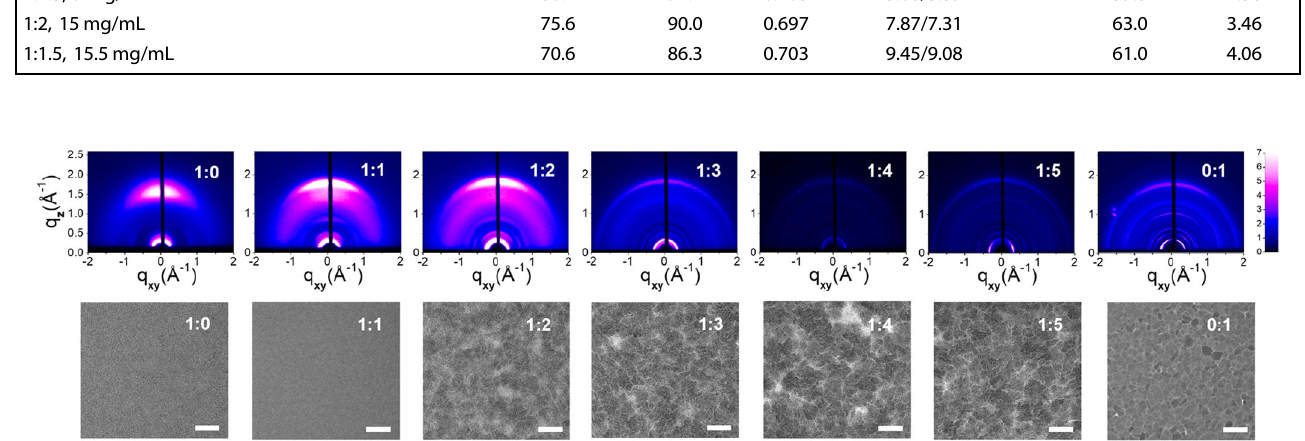
Fig. 4 GIWAXS and TEM characterization of photovoltaic BHJ fi lms prepared with various D – A ratios. The scale bar is 200